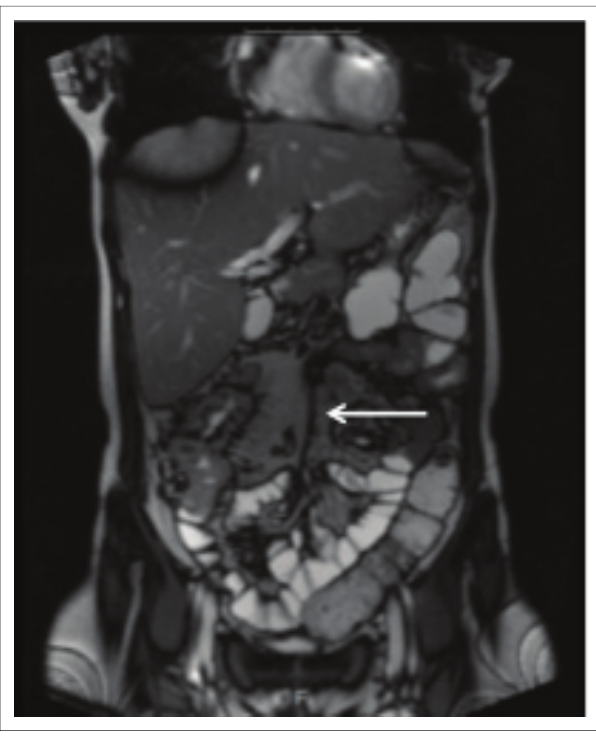
MRI, Magnetic resonance imaging; TB, Tuberculosis. FIGURE 8: Coronal T2-weighted MRI. This image is of a 30-year-old male with a CD4 count of < 100 cells/ μ L, demonstrating a 4 cm segment of thickened distal and terminal ileum, with localised perforation. Confirmation of TB was made upon endoscopic biopsy and histology.